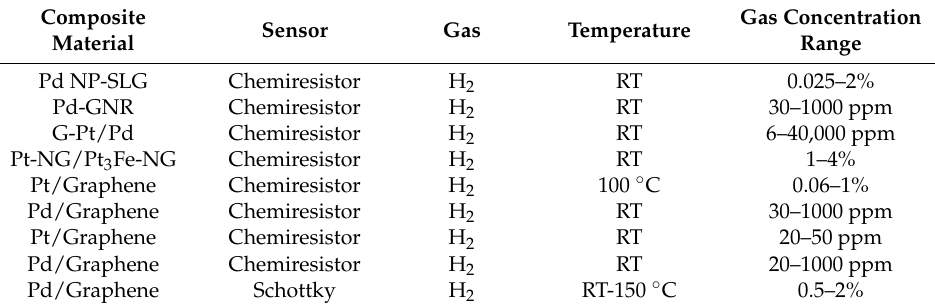
Table 1. Examples of graphene–noble metal hybrid H 2 sensors.